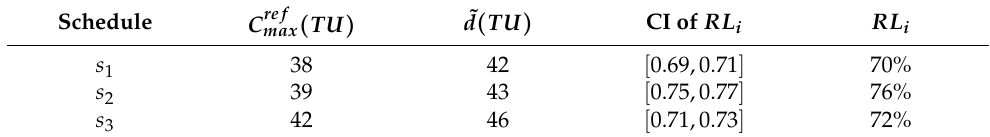
Table 2. Robustness evaluation